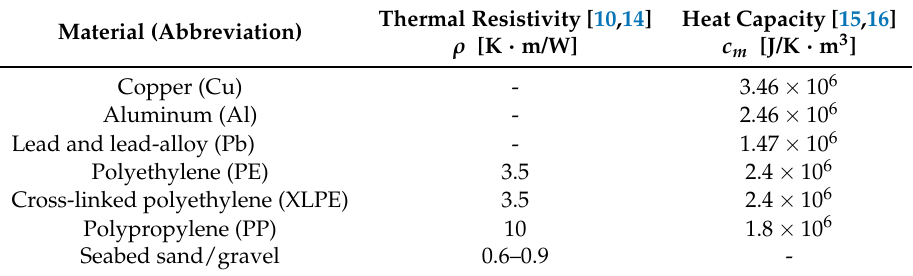
Table 1. Commonly used thermal resistivity for materials and